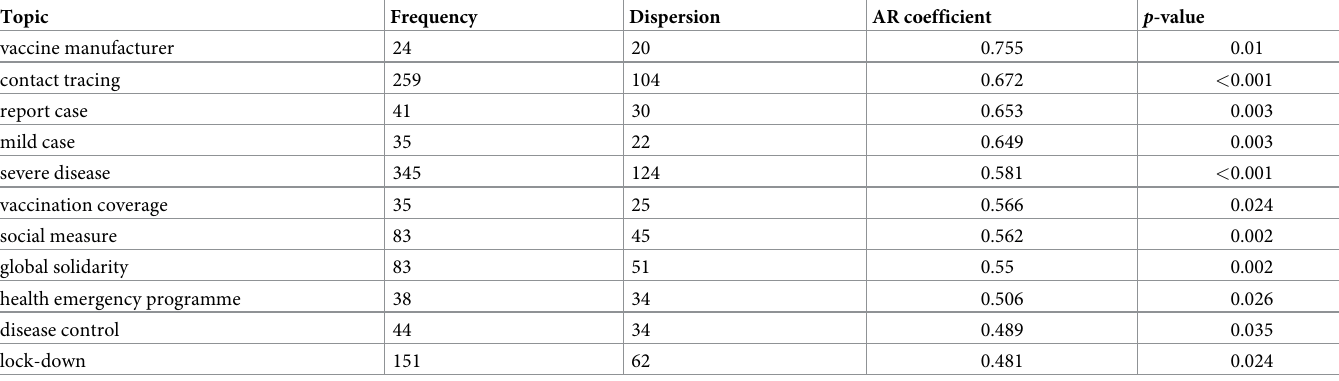
Table 2. Hot topics in the WHO COVID-19 press